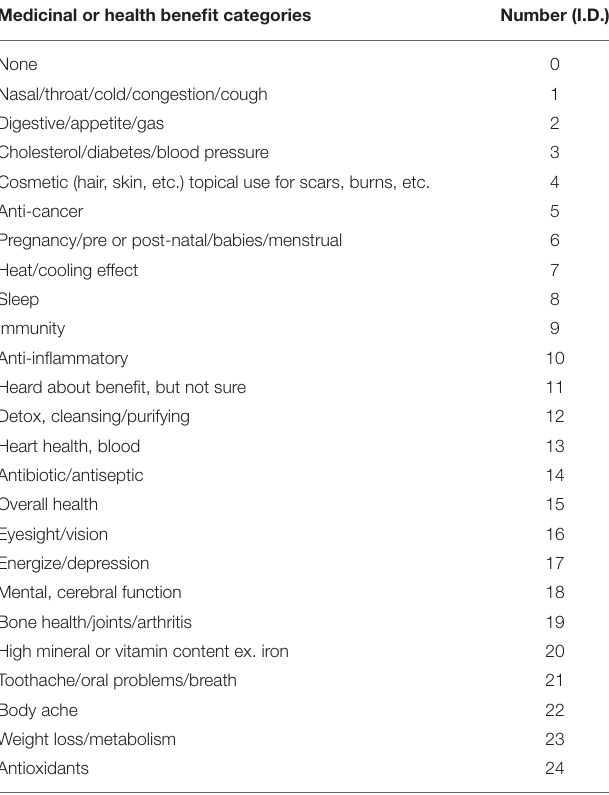
TABLE 4 | Medicinal and/or health benefit categories and identification (I.D.) number (corresponding with Table 5 ). Medicinal or health benefit categories Number (I.D.)